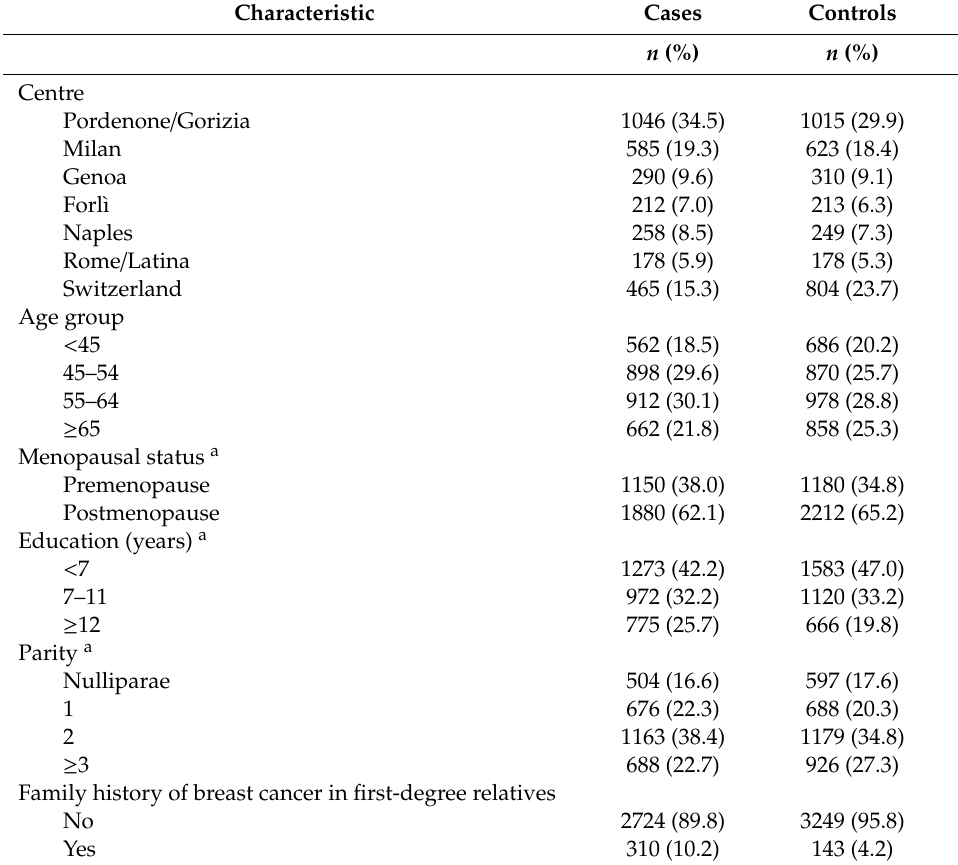
Table 1. Distribution of 3034 cases of breast cancer and 3392 controls according to selected characteristics. Italy and Switzerland,